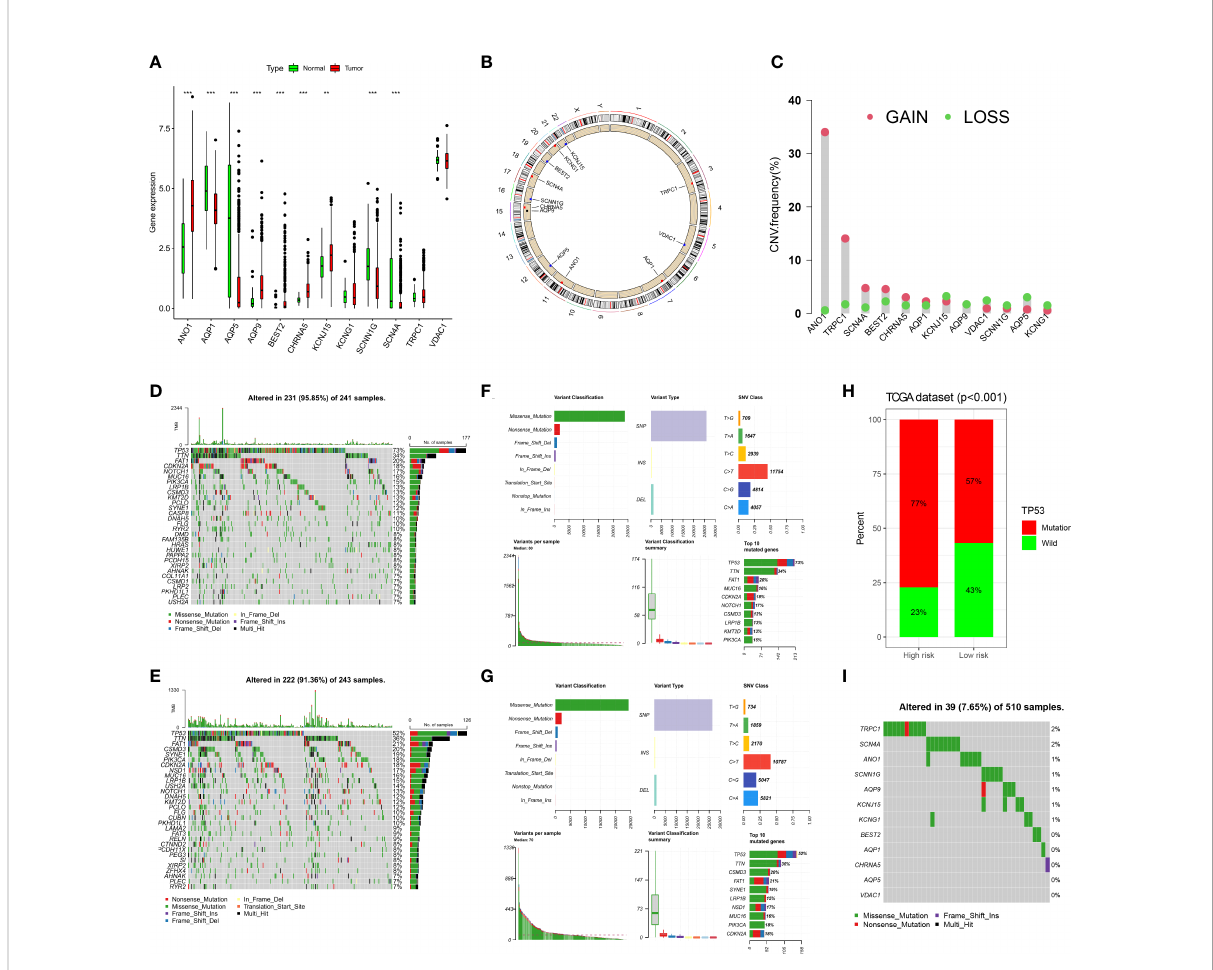
FIGURE 9 The landscape of genetic and expression variation of 12 ion channel genes in TCGA dataset. (A) Comparison of expression levels of 12 ion channel genes in tumor tissues and normal tissues. (**p<0.01, ***p<0.001). (B) The location of 12 ion channel genes on the chromosome. (C) Copy number variation of 12 genes. (D, E) Somatic mutations in the high-risk group. (F, G) Somatic mutation in the low-risk group. (H) Mutation difference of TP53 between the two groups. (I) The somatic mutation of 12 ion channel